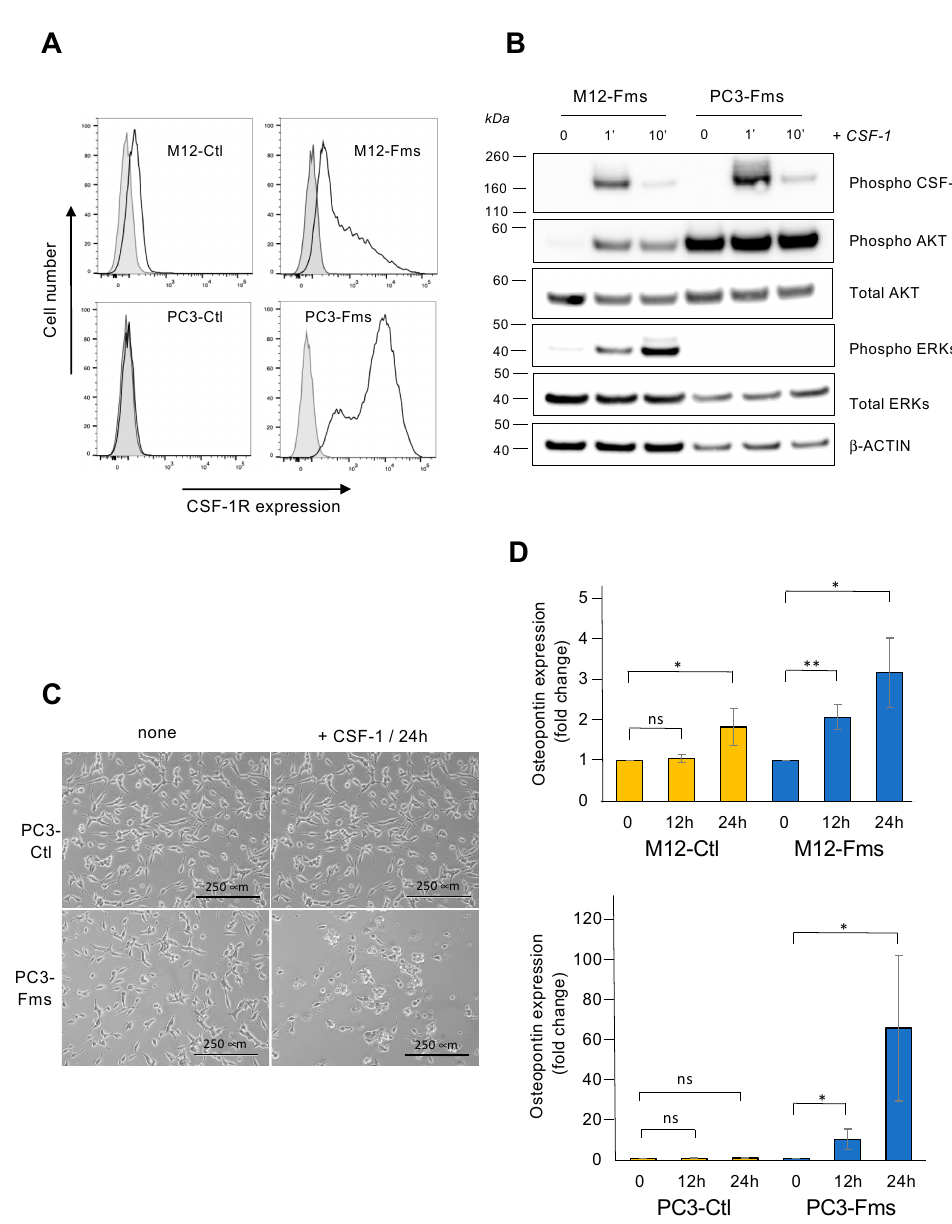
Figure 6. The CSF-1 receptor is functional in human prostate cells and increases spp1/osteopontin gene expression. ( A ) Two human prostate cancer cell lines, M12 and PC3, were transfected with human c-fms cDNA encoding CSF-1R or with the empty vector as a control (Ctl). Selected cell populations were analyzed for cell surface expression of CSF-1R by flow cytometry: each cell population transfected either with an empty vector (M12-Ctl and PC3-Ctl) or with c-Fms-vector (M12-Fms and PC3-Fms) were stained with anti-CD115-PE antibody (empty graph) or no antibody (grey filled graph). ( B ) Western blot analysis of CSF-1R signaling in Fms-expressing prostate cells after CSF-1 stimulation for 1 and 10 min. All cropped blots were run under the same experimental conditions. ( C ) Representative photographs (n = 3) of PC3-Ctl cells (upper panels) and PC3-Fms cells (lower panels) cultured in the absence (left panels) or the presence of CSF-1 (right panels) for 1 day. ( D ) Relative expression of spp1/osteopontin mRNA was assessed by qRT-PCR performed in triplicate (normalized against RPLP0). M12-Clt and M12-Fms cells (upper panel) and PC3-Ctl and PC3-Fms cells (lower panel) were cultured in the absence or the presence of CSF-1 for 12 h and 24 h. The values are expressed as mean ± s.d. of 3 independent experiments. * p < 0.05, ** p < 0.01, ns = not